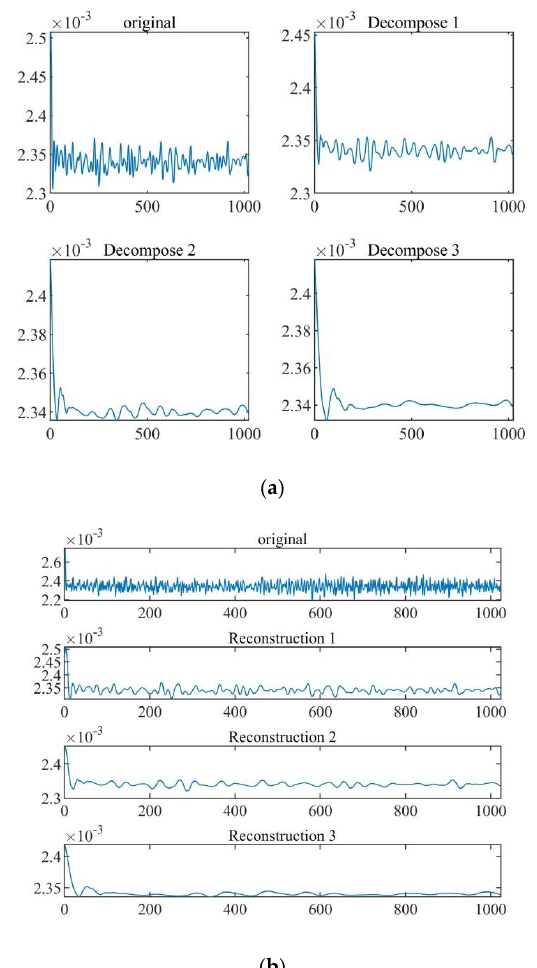
Figure 4. Wavelet decomposition and reconstruction of signals. ( a ) Decomposition signals, ( b ) reconstructed signals.